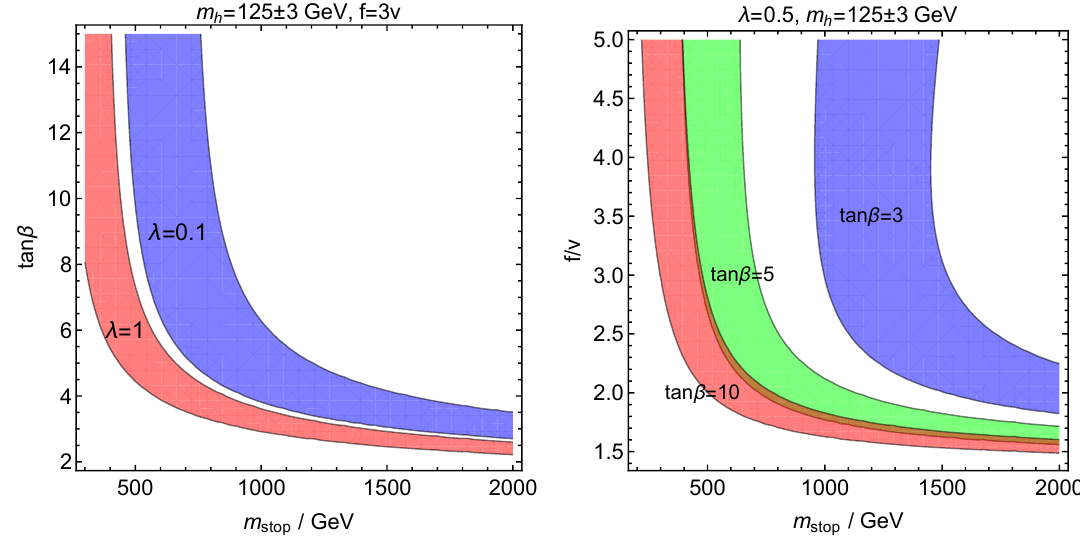
Figure 1 . The SM-like Higgs mass of m h = 125 (cid:6) 3 GeV in the plane m stop -tan (cid:12) for (cid:12)xed f = 3 v with (cid:21) = 0 : 1 and (cid:21) = 1 (left panel) and in the plane m stop - f=v for tan (cid:12) = 3 ; 5 ; 10 (right panel) assuming the decoupling limit of SUSY Twin Higgs